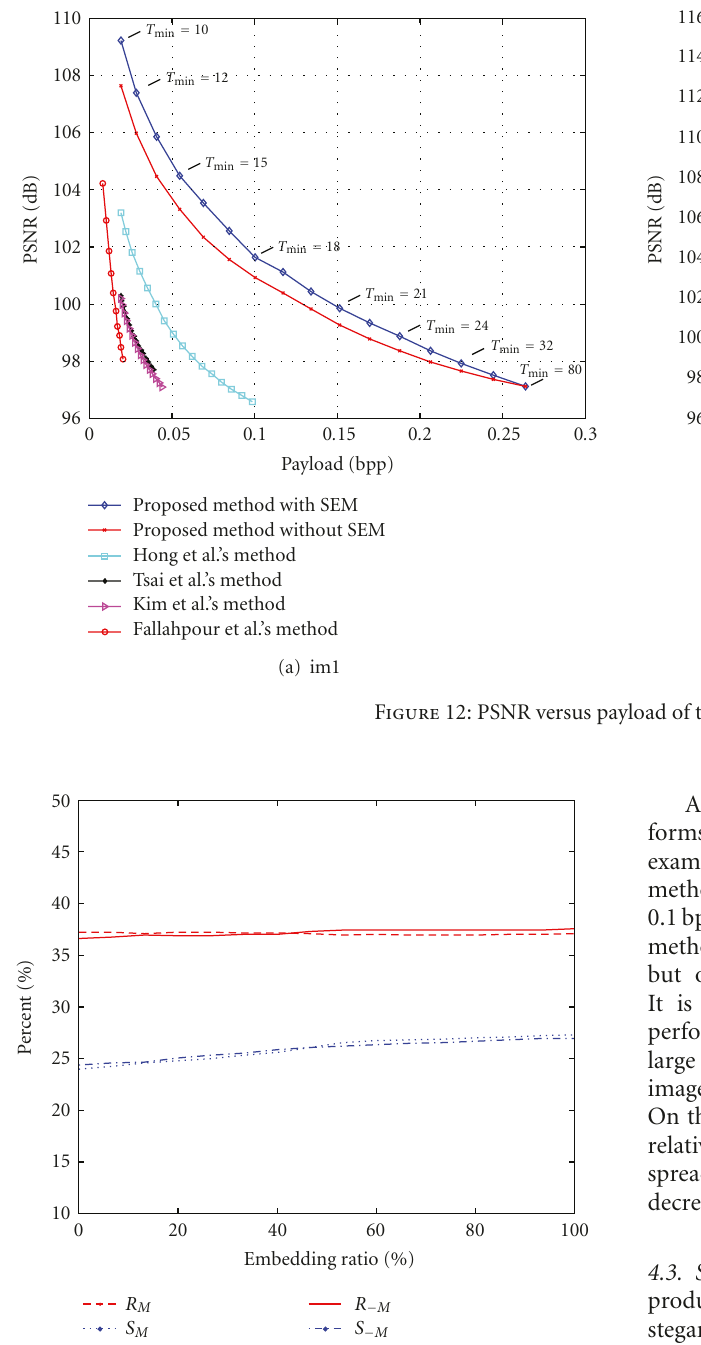
is based on partitioning the image into nonoverlapping blocks, and these blocks are prioritized based on objective or subjective quality. Data are then embedded into each block at the pixel level using histogram-shifting technique. The results obtained from each method are shown in Figure